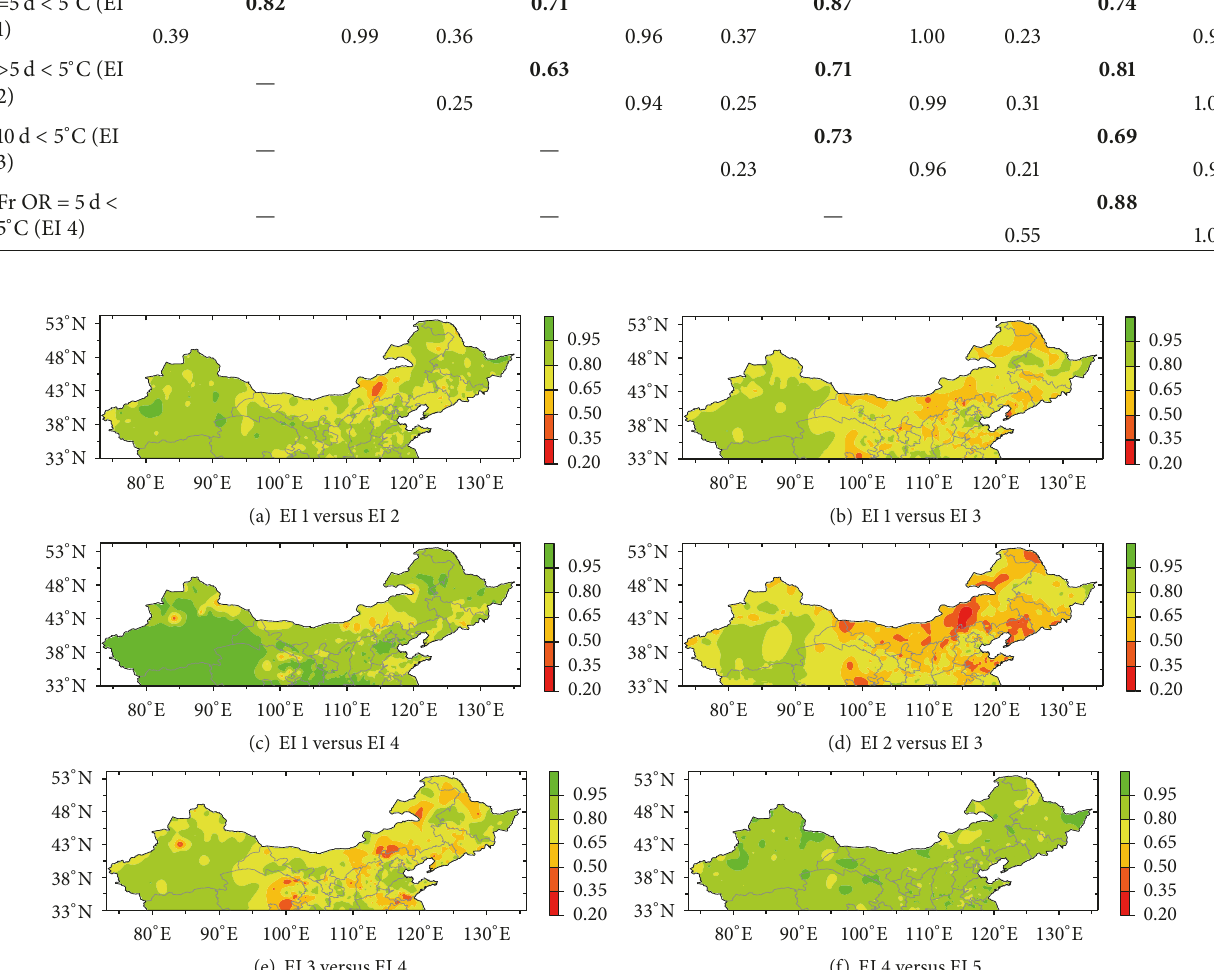
Figure 4: Correlation coefficients for combinations of the end indices of growing season in northern China.